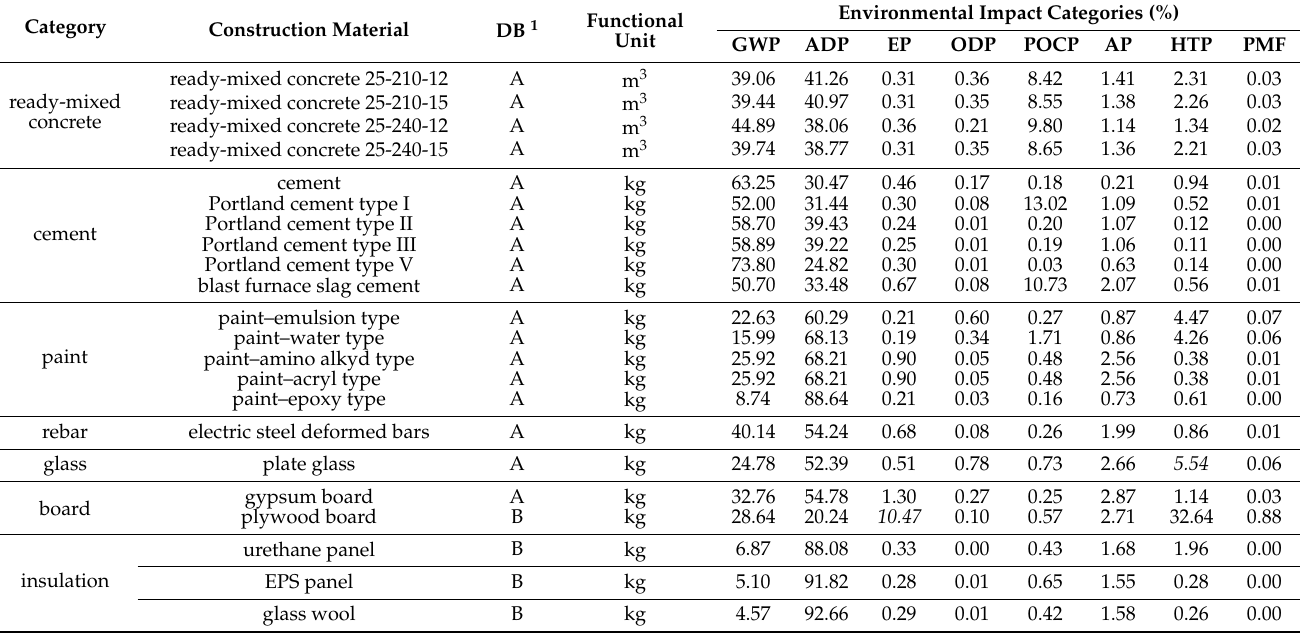
Table 6. Endpoint coefficients corresponding to the environmental impact categories of construction materials [16].